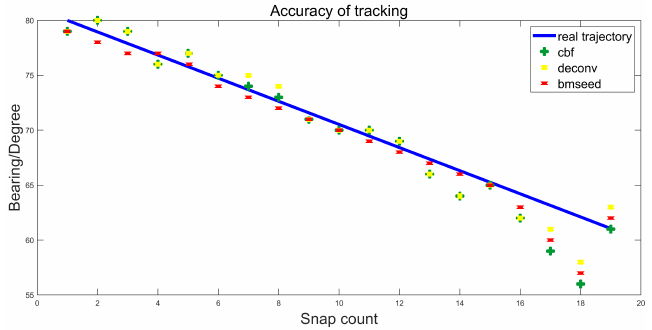
Figure 9. Accuracy of tracking